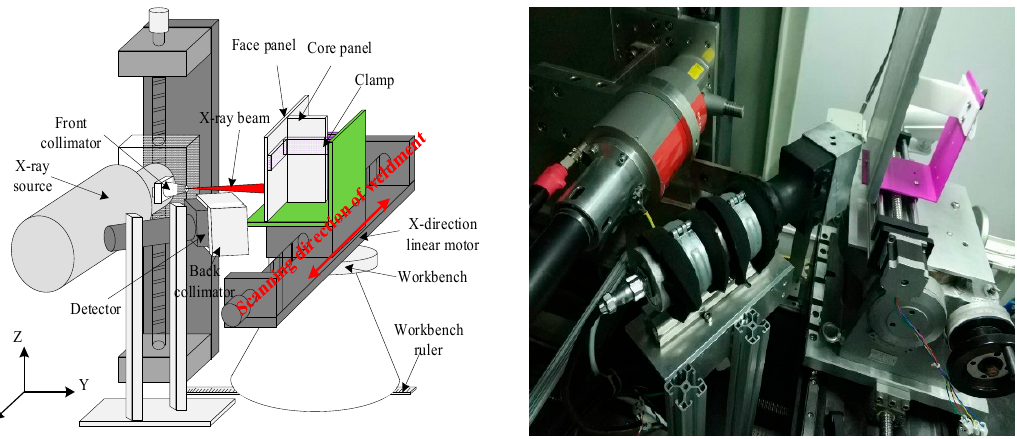
Figure 4. Schematic diagram ( left ) and the real experimental system ( right ).